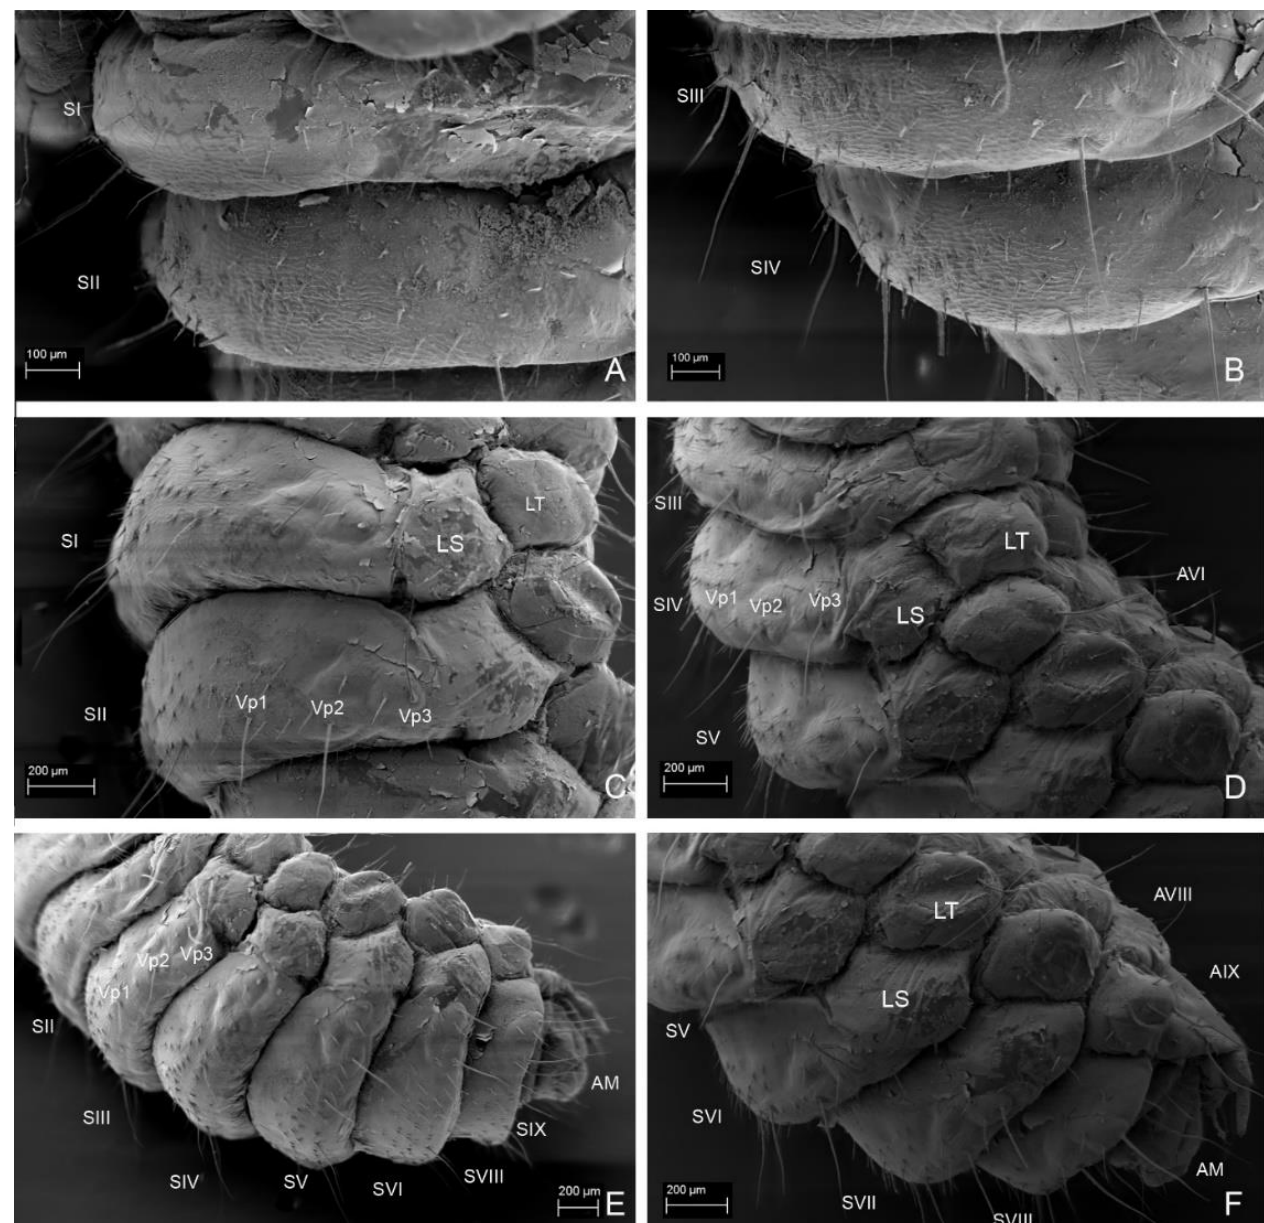
Figure 18. Leiodes cinnamomea. Details of larval morphology of instar III. Abdominal sternites. ( A ) Sternites I, II. ( B ) Sternites III, IV. ( C ) Sternites I, II, lateral view. ( D ) Sternites III–V, lateral view. ( E ) Sternites II–IX with urogomphi and anal membrane. ( F ) Sternites V–IX. Abbreviations: AI—AIX— abdominal tergites I–IX; AM—anal membrane; LS—laterosternite; LT—laterotergite; SI–IX— abdominal sternites I–IX. The other abbreviations refer to the terminology of setae.